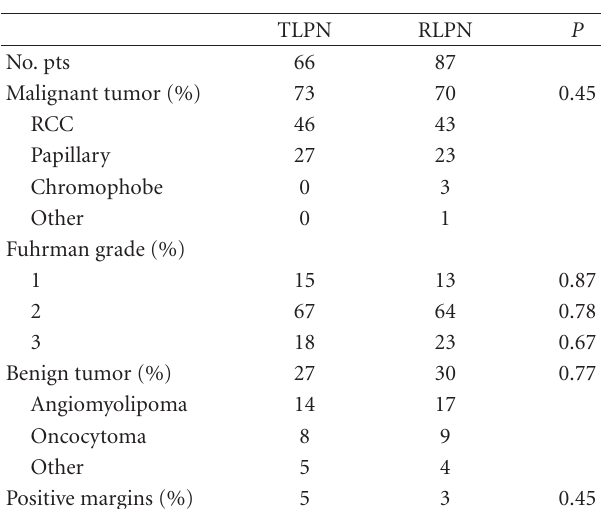
transfusion rate and urine leakage are comparable to Gill’s et al. experience [21]. Compared with OPN, LPN for T1A tumors had the same oncologic results. In 2004, Allaf et al. reported on 48 patients who underwent TLPN for pathologically proven renal cell carcinoma [22]. Mean tumor size was 2.4 cm, and final pathologic stage was pT1 in 88% and pT3a in